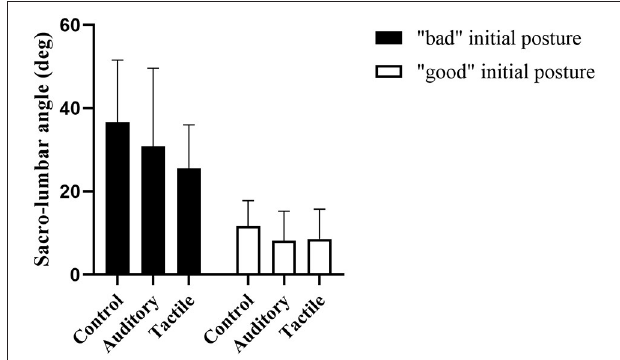
FIGURE 6 | Condition effect in initially “good” and “bad” spine posture to visually show the interaction between initial movement capabilities and feedback modality. The two groups were defined using a median split on the baseline performance at 20.5 ◦